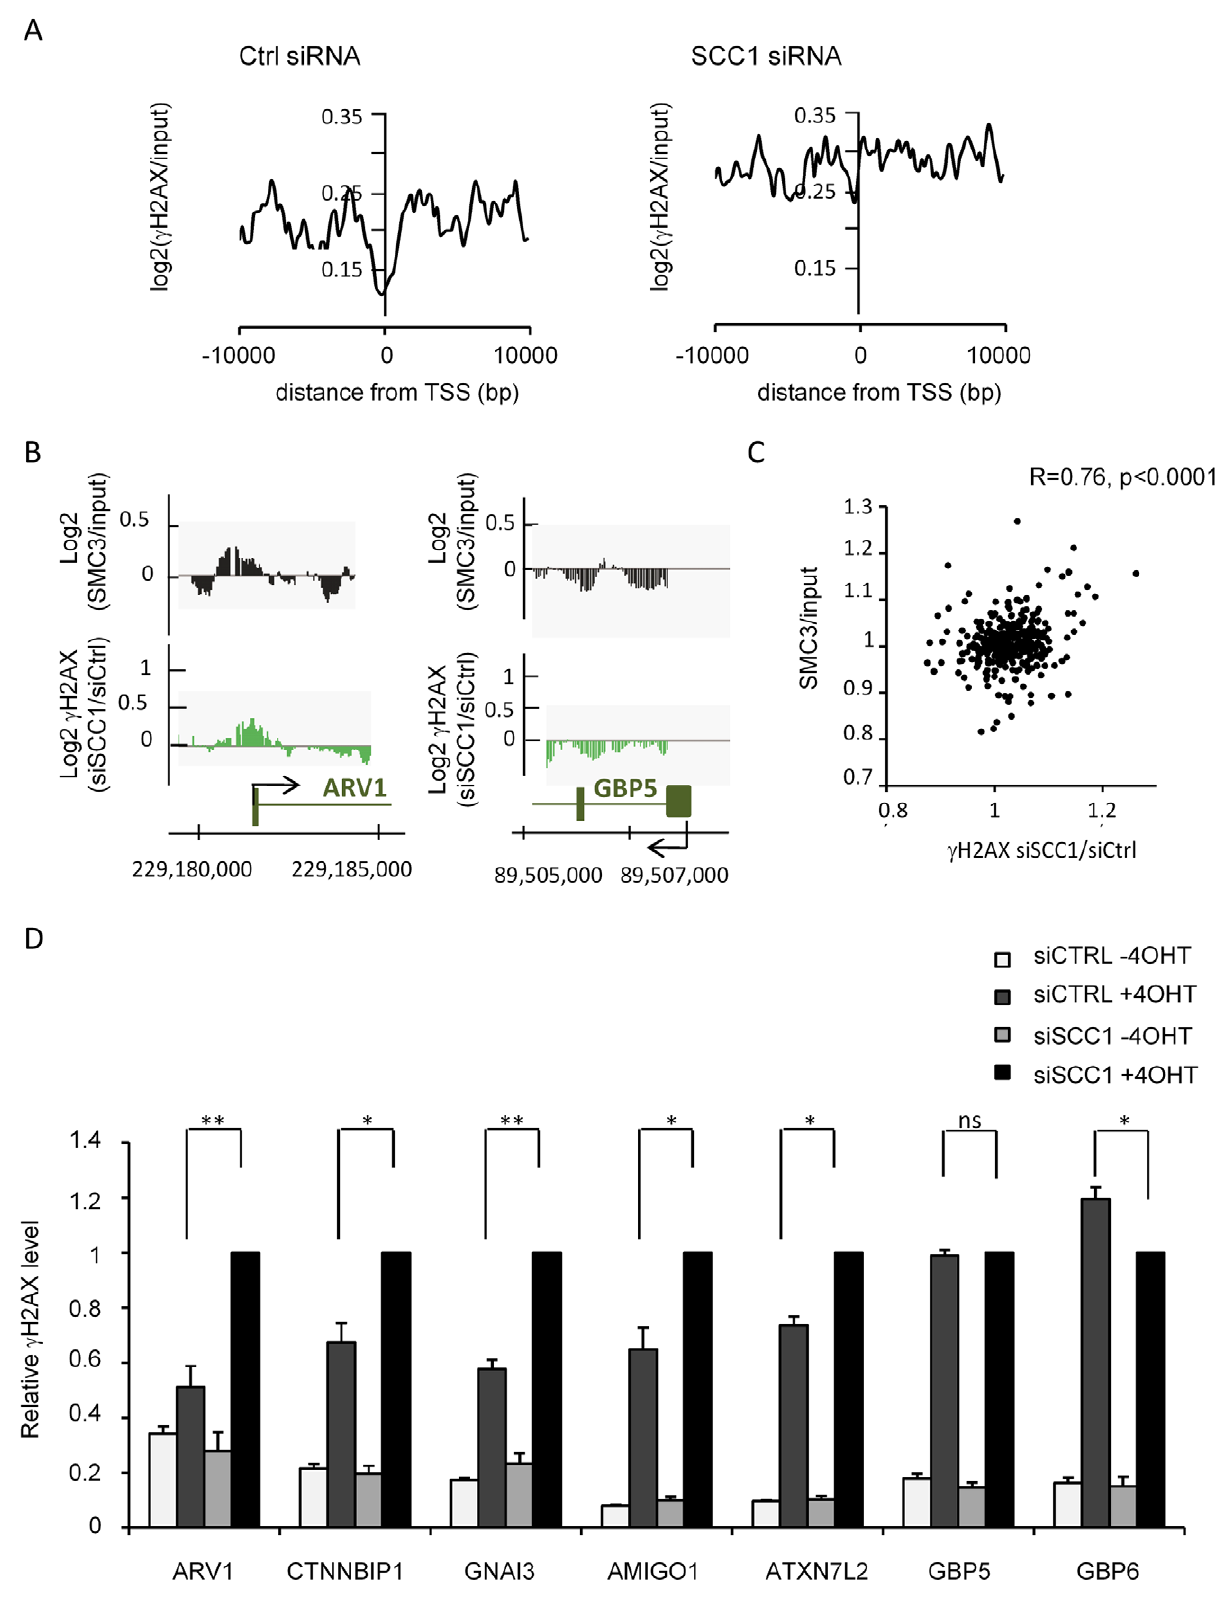
Figure 4. c H2AX accumulates on cohesin-bound genes and promoters in SCC-deficient cells. A, The c H2AX/input signal after 4OHT treatment (average from duplicate experiments), smoothed using a 200 bp window, is plotted relative to the TSS from all 359 genes located within c H2AX domains. The left panel shows the distribution in control cells and the right panel shows the distribution in cells transfected with SCC1 siRNA.